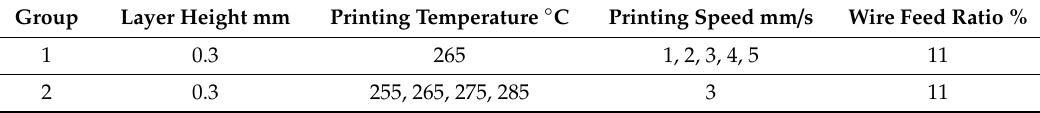
Table 2. Printing